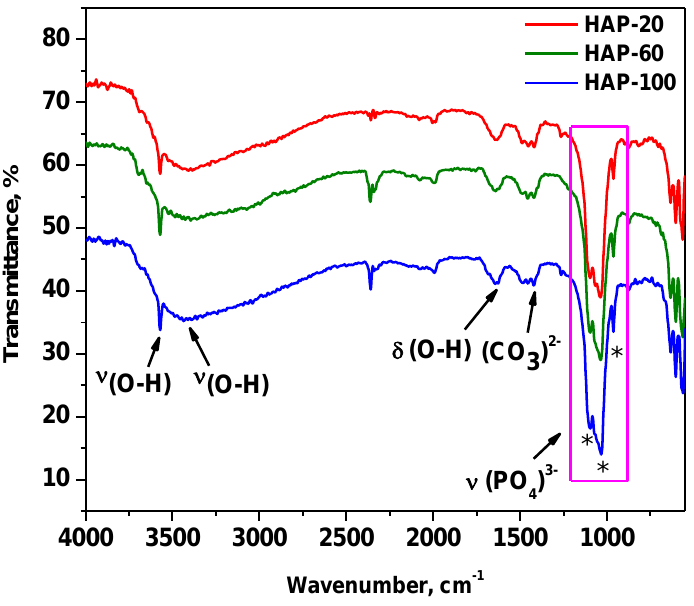
Figure 1. FT-IR spectra of HAp